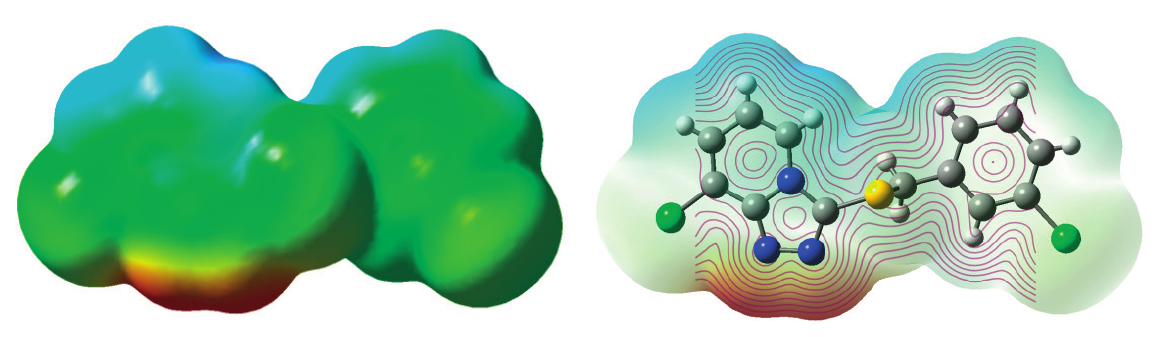
Figure 4. Electrostatic potential mapping on the electron density (isovalue =